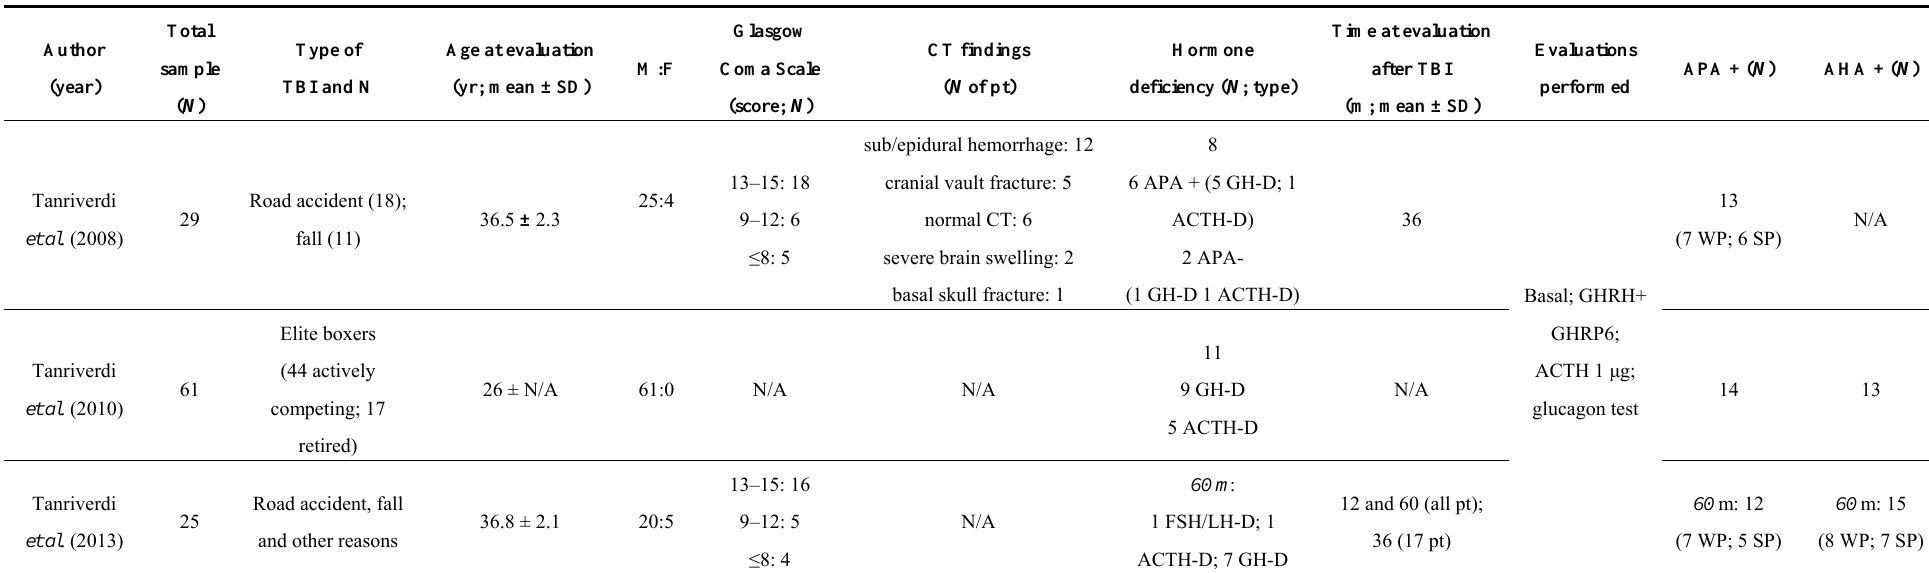
Table 1. Summary of the studies assessing the association between hypothalamic-pituitary autoimmunity and traumatic brain injury (TBI)-induced hypopituitarism.